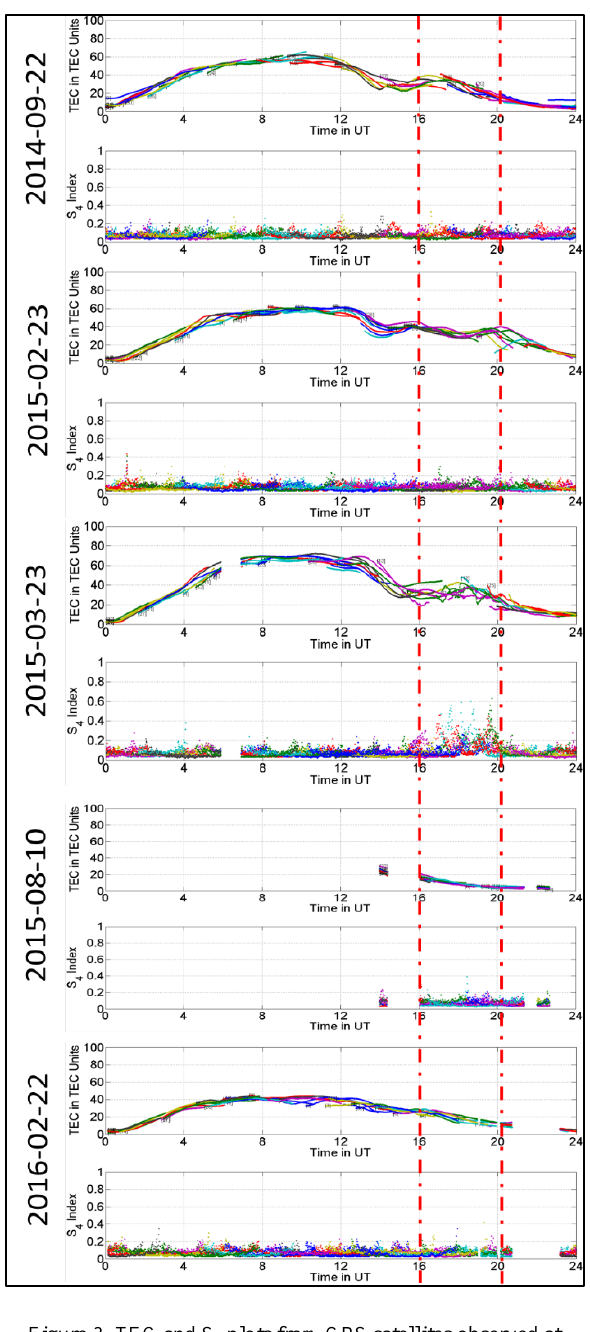
Figure 3. TEC and S 4 plots from GPS satellites observed at Tirunelveli. High scintillation activity can be observed